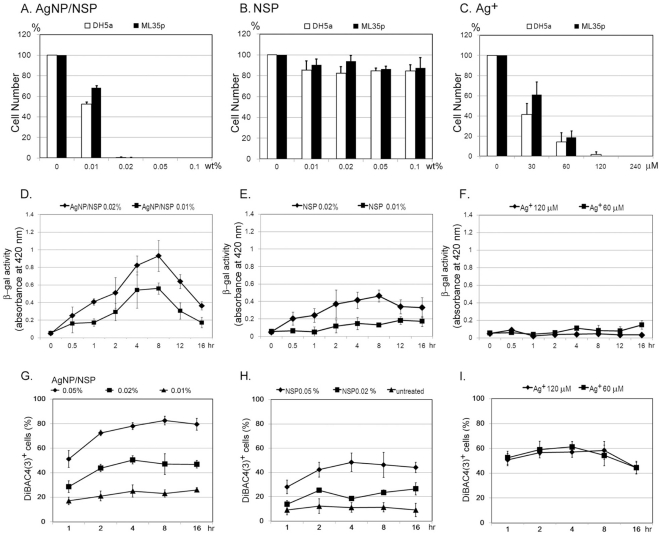
Disrupted membrane permeability and polarity by AgNP/NSP.Approximately 1×105
E coli DH5α and ML35p strains were spread on NSP (A), AgNP/NSP (B) or silver nitrate (C) containing LB agars, where nanohybrid materials were mixed with at the indicated concentrations. These colonies were counted after overnight incubation at 37°C. After treating E. coli ML35p with the nanomaterials (D, E) or silver nitrate (F) in LB broth, the activity of the released intracellular β-galactosidase in the supernatant was kinetically determined by reacting with ONPG and quantitatively measured with spectrophotometry at 420 nm. The number of fluorescent DiBAC4(3)+ cells in NSP- (G), AgNP/NSP- (H) or silver nitrate- (I) treated E. coli DH5α were determined by FACS analysis.